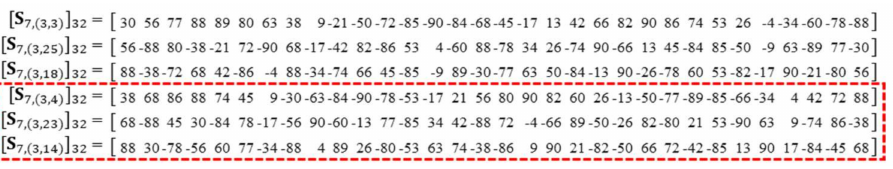
Figure 14. Grouped 32 − point DST − 7 transform kernel elements.